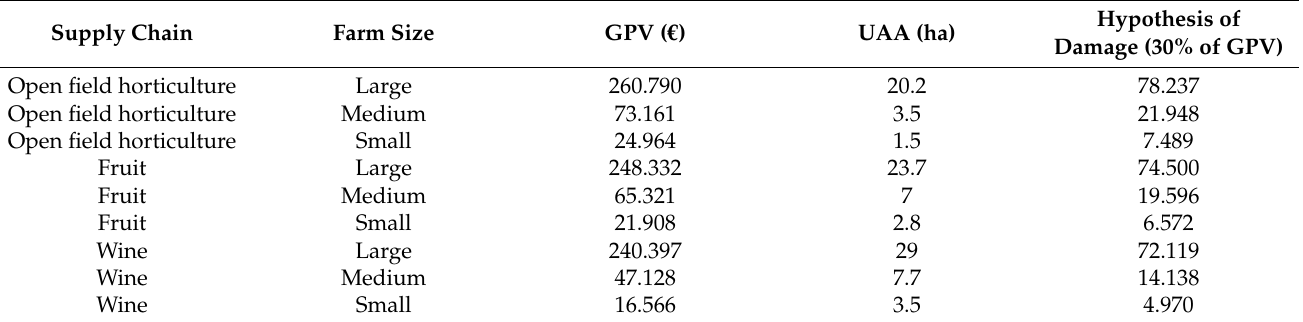
Table 1. FADN data used for the cost-effectiveness analysis of adopting the measure (average farm values